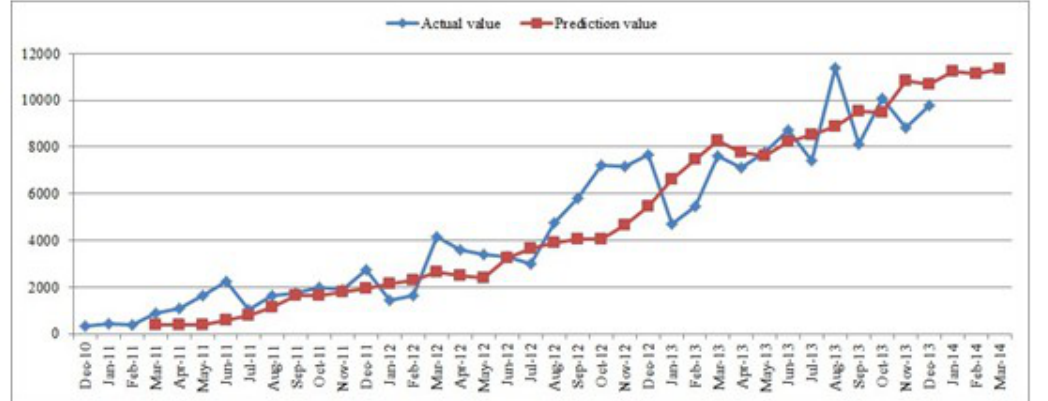
Figure 3. Prediction value of EVs monthly sales from Dec. 2010 to Mar. 2014